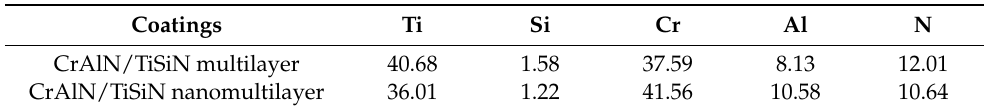
Table 2. Chemical composition of the two coatings (wt.%).